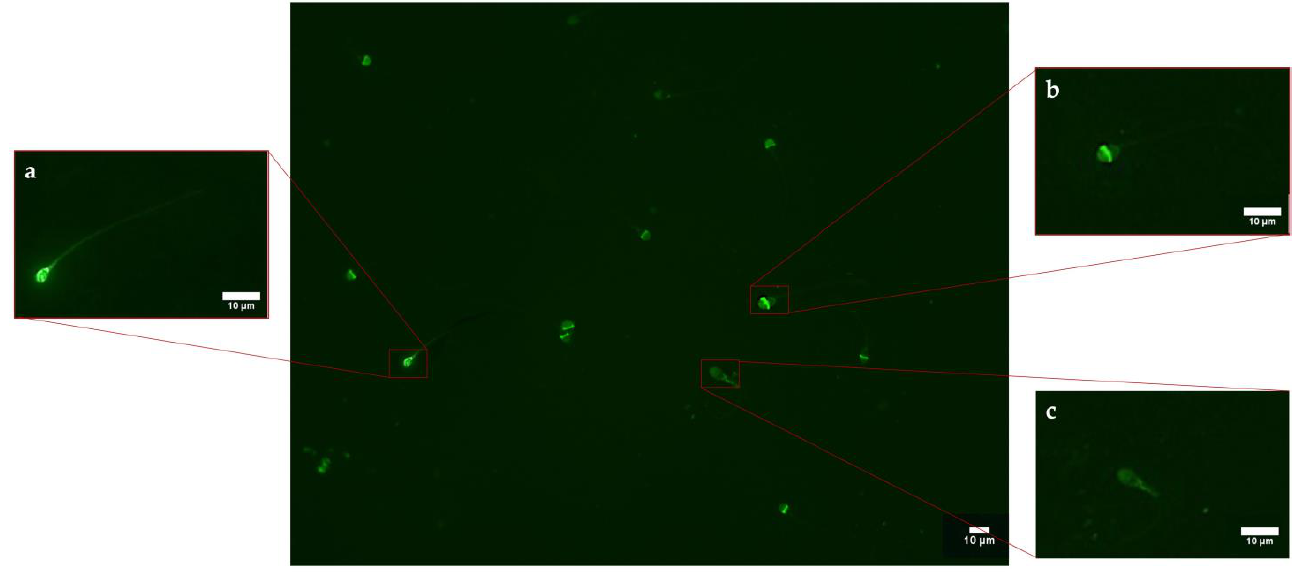
Figure 2. Observation of a casual field of spermatozoa subjected to PNA-FITC test to assess acrosome integrity: ( a ) spermatozoon FITC+ with intact acrosome; ( b ) FITC+ spermatozoon only at the level of the middle region of the head; ( c ) spermatozoa FITC−.